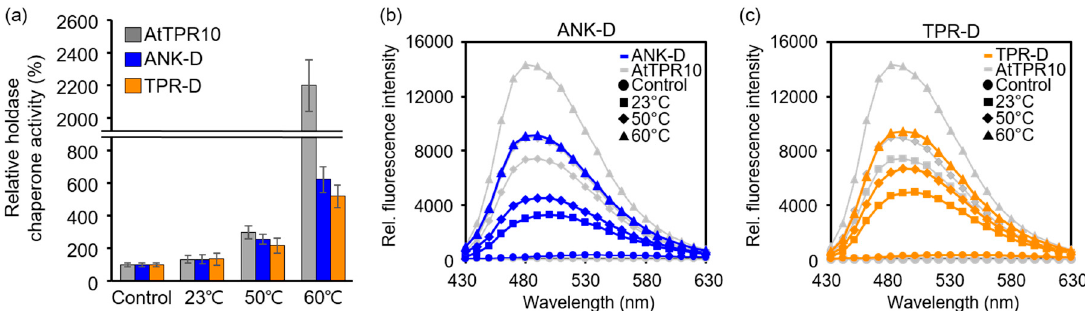
Figure 8. Comparison of the chaperone activity and hydrophobicity of AtTPR10, ANK-D, and TPR-D at different temperatures. ( a ) Relative chaperone activity of AtTPR10, ANK-D, and TPR-D at 23 °C, 50 ◦ C, and 60 ◦ C. ( b ) and ( c ) Hydrophobicity analysis of ANK-D ( b ) and TPR-D ( c ), along with that of AtTPR10, upon incubation with bis-ANS at 23 ◦ C, 50 ◦ C, and 60 ◦ C for 30 min. The fluorescence of bis-ANS was measured using a fluorometer, with excitation at 390 nm and emission at 430–630 nm. The representative results are means of at least three independent experiments.